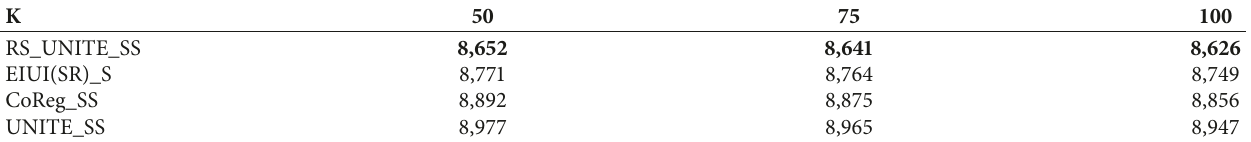
Table 6: Comparison of perplextiy metrics on